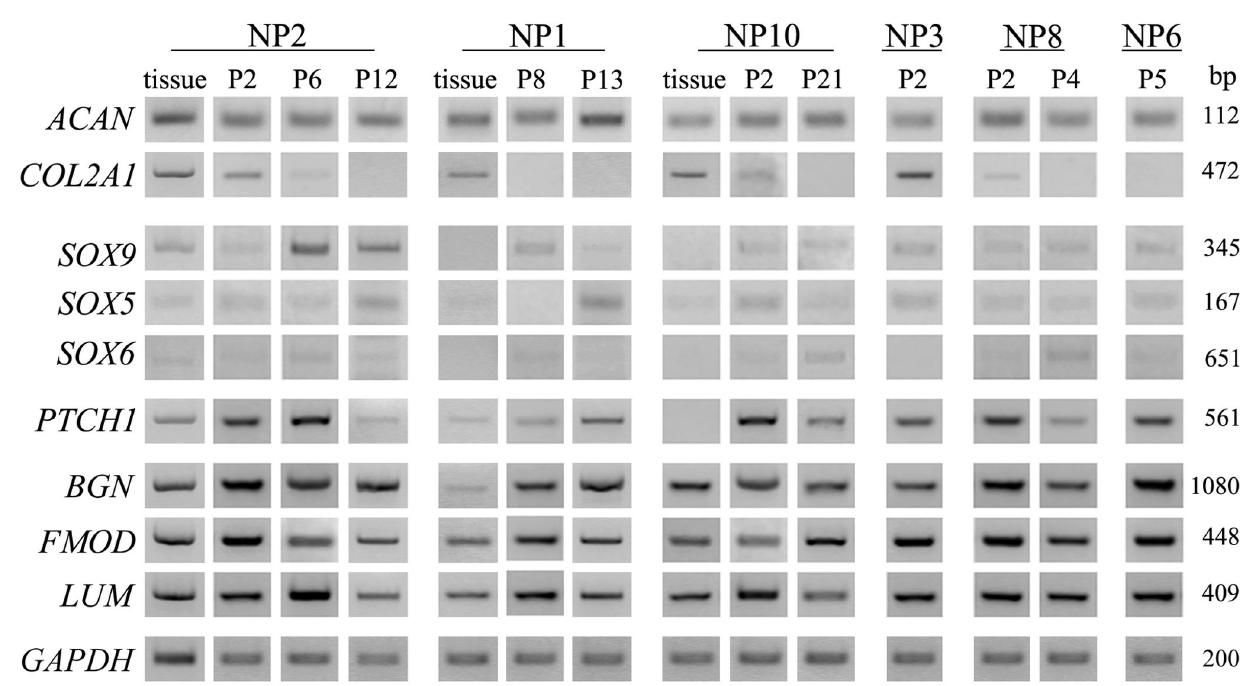
Figure 3. Chondrocytic marker expression remains stable over many cell passages of NP cell cultures. Representative images of RT-PCR results demonstrate expression levels of ACAN; COL2A1; SOX 5,6, and 9; PTCH1; BGN ; FMOD; and LUM in NP tissue and in early and late passage of NP cells from different patient samples, and highlight that, under monolayer culture expansion, messages for ECM proteoglycans aggrecan, biglycan, fibromodulin, and lumican were sustained at similar levels throughout passaging. For each sample, the expression of each gene was examined using identical amounts of cDNA template, as for the housekeeping GAPDH (shown at the bottom